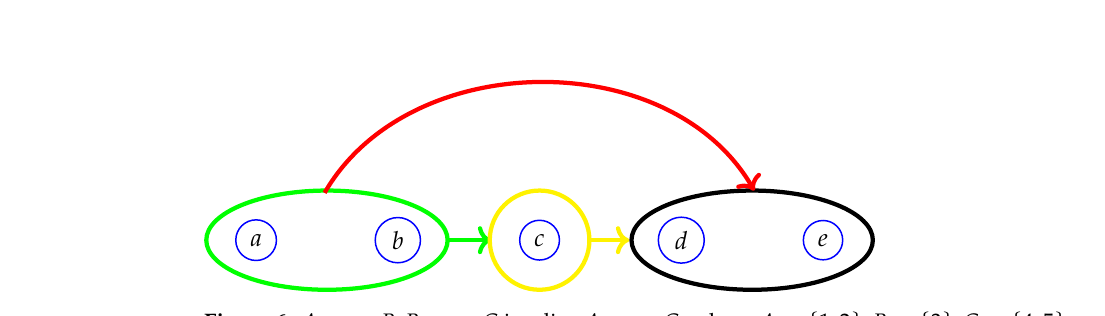
Figure 6. A = ⇒ B , B = ⇒ C implies A = ⇒ C , where A = { 1,2 } , B = { 3 } , C = { 4,5 }